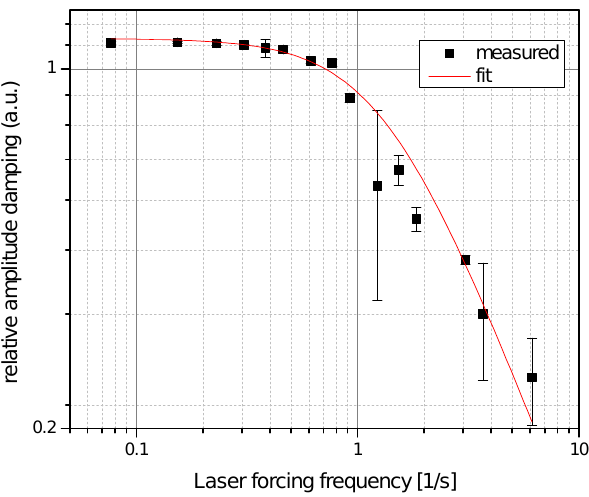
Figure 2. Measured heat transfer velocities plotted against the locally measured friction velocity. Dates are given in YYYY/MM/DD.